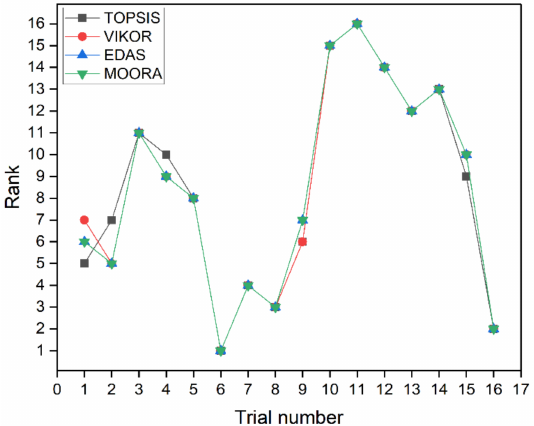
Figure 9. Comparison of rankings derived by MCDM techniques for case study